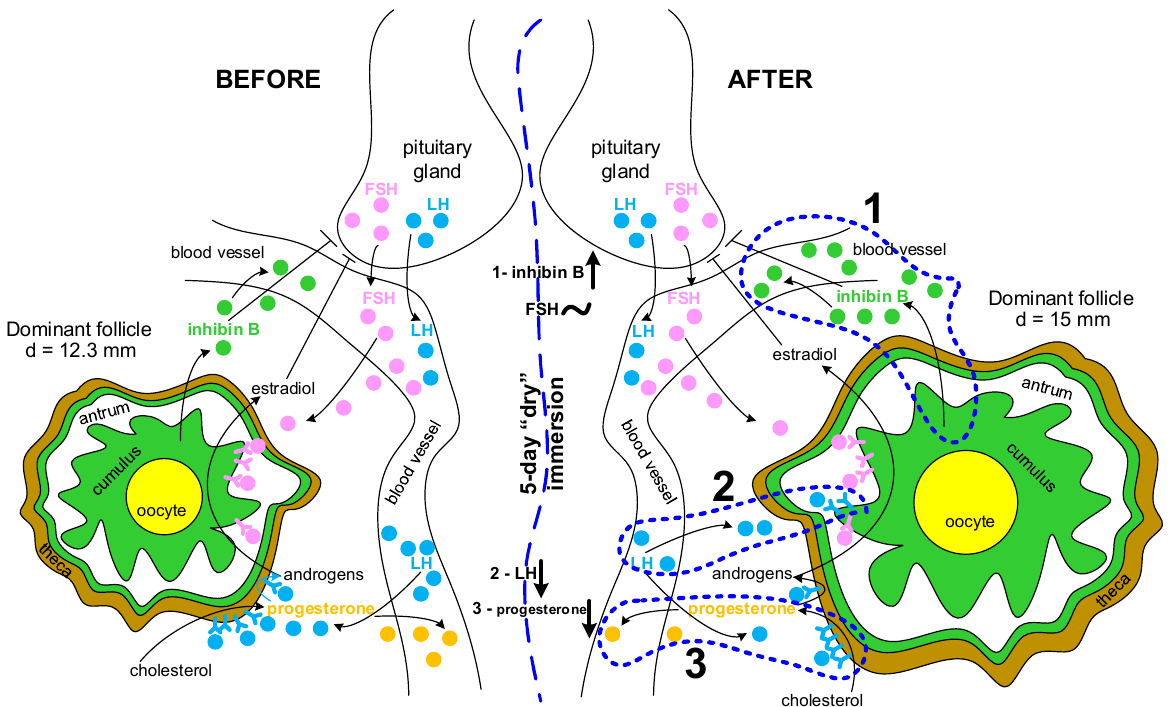
Figure 4. Possible scheme of events leading to a change in the concentration of hormones and the diameter of the dominant follicle after a 5-day “dry” immersion. Changes in hormone content are labeled as follows: ↑ —increase, ↓ —decrease, ~—unchanged. (1) As a result of staying in “dry” immersion from 10 to 15 days during the previous menstrual cycle, an increase in the number of granulosa cells of the growing antral follicles occurs. This leads to an increase in the growth of the dominant follicle in the next cycle and an acceleration of its maturation. Thus, the diameter of the dominant follicle increases, and, due to the increase in the number of granulosa cells, the production of inhibin B increases (marked with a small green circle), as well as its concentration in the blood. (2) Accelerated maturation of the follicle leads to an earlier appearance of LH receptors on granulosa cells and, consequently, to their greater utilization in the bloodstream. Accordingly, the concentration of LH (marked with a small light-blue circle) in the blood falls. (3) A decrease in the concentration of LH in the blood leads to its deficiency for receptors located on the theca cells and, consequently, to a decrease in the synthesis of progesterone (marked with a small yellow circle) and a decrease in its concentration in the blood. The arrows indicate the migration of hormones, the blue dashed line indicates the fluxes that have changed after